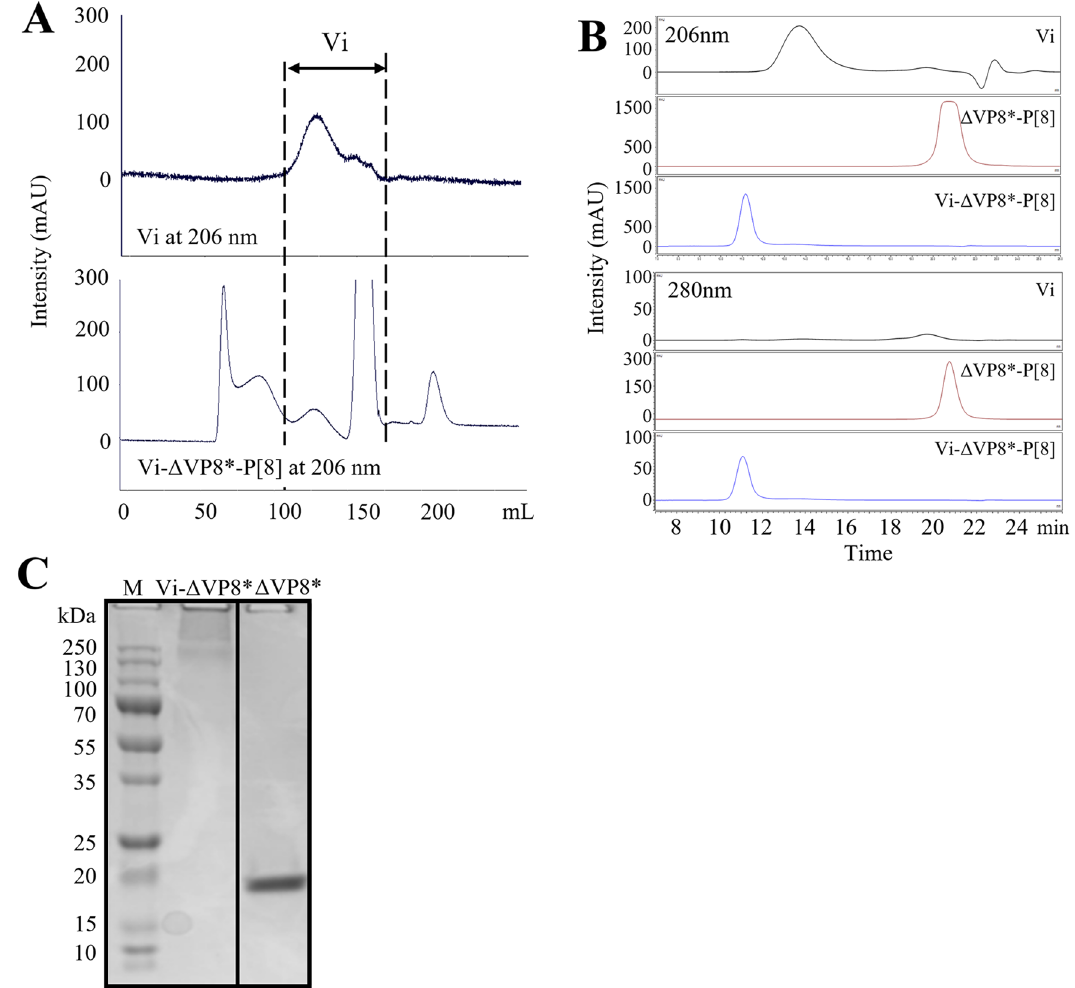
Figure 3. Physicochemical characteristics of the glycoconjugates. ( A ) Sephacryl S-1000 profile of Vi and Vi-ΔVP8*-P[8]. Vi-ΔVP8*-P[8] was purified on Sephacryl S-1000 (1.6 cm × 90 cm) eluting with 10 mM NaH 2 PO 4 , 5 mM NaCl, pH 7.0 at a flow rate of 0.5 mL/min. ( B ) SEC-HPLC profiles of Vi-ΔVP8*-P[8]. TSKgel G5000 PW XL column, 0.1 M NaCl, 0.1 M NaH 2 PO 4 , 5% ACN, pH 7.2; 0.5 mL/min. flow rate. Vi polysaccharide, ΔVP8*-P[8], and Vi-ΔVP8*-P[8] ( C ) SDS-PAGE profile of Vi-ΔVP8*-P[8] (Lane 1: Marker, Lane 2: Vi-ΔVP8*-P[8] and Lane 3: ΔVP8*-P[8]). 12% gel, SimplyBlue staining. The grouping of gels cropped from different parts of the same gels. The full-length gels are presented in Supplementary